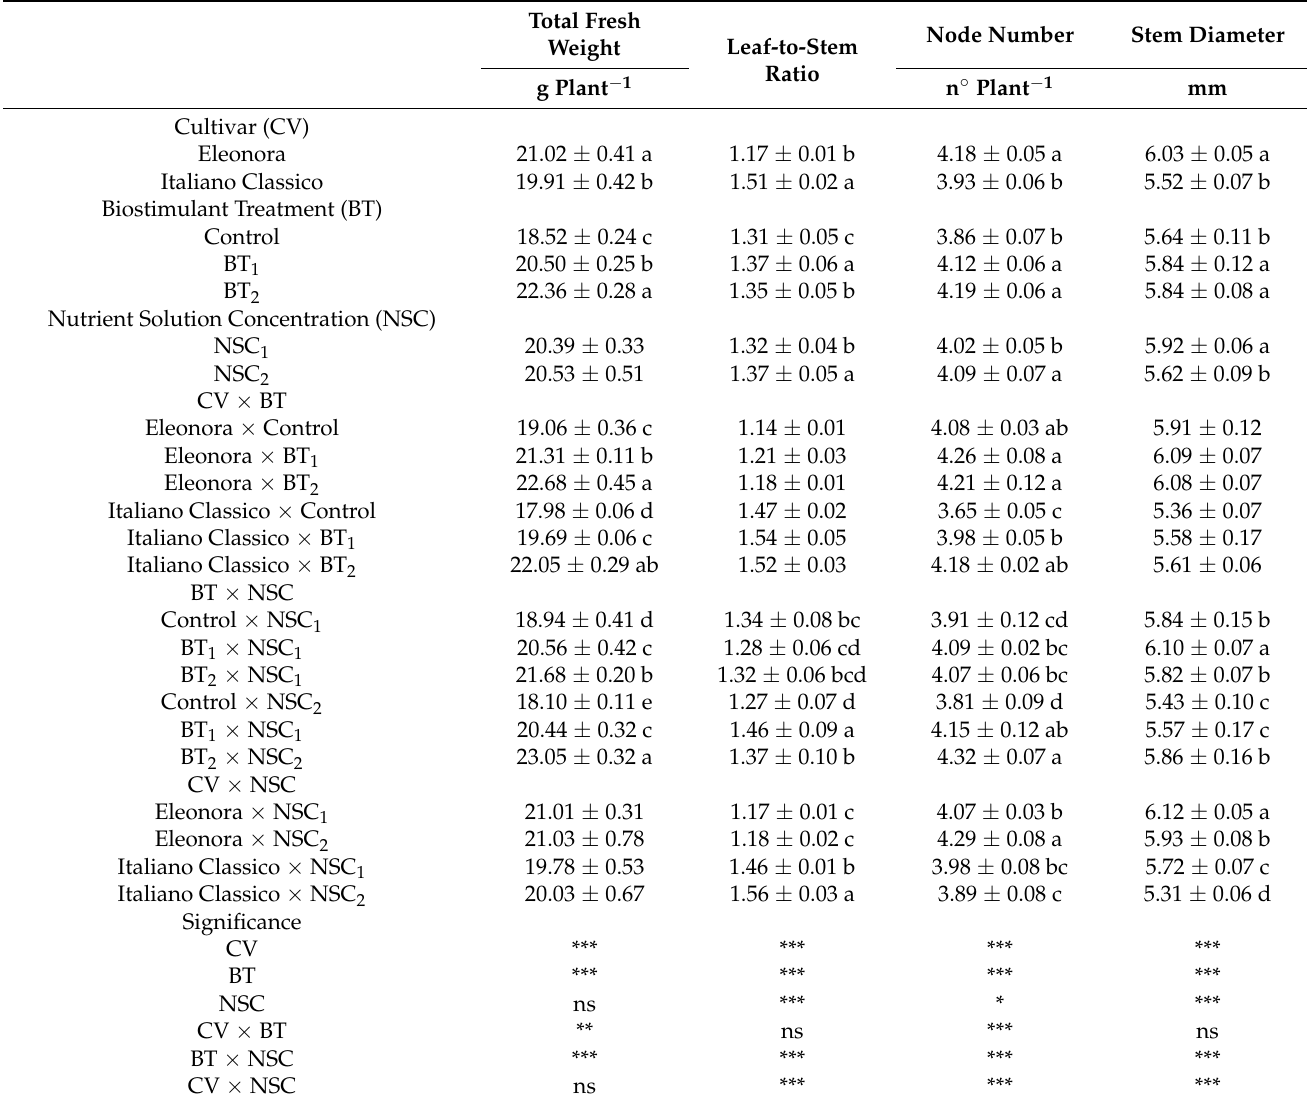
Table 1. Analysis of variance and mean comparisons for total fresh weight, leaf-to-stem ratio, node number, and stem diameter of Eleonora and Italiano Classico basil cultivars grown in floating raft system under two different nutrient solutions treatments and two rates of biostimulant